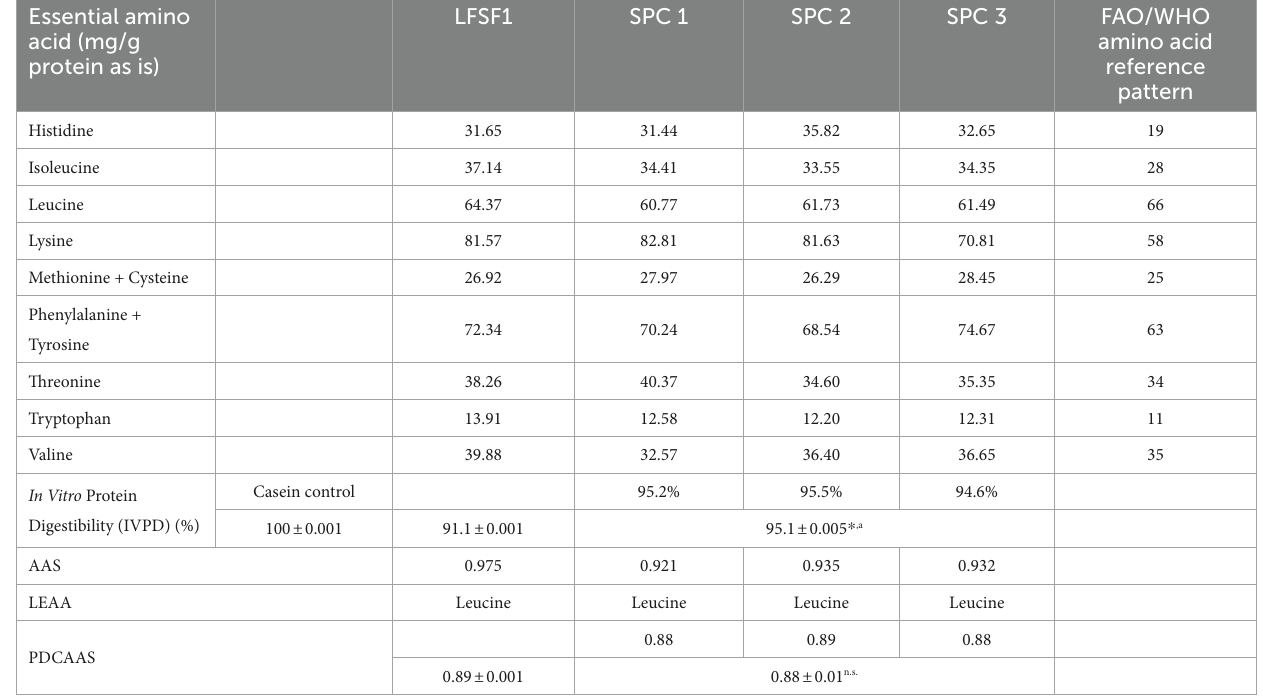
TABLE 5 Protein digestibility corrected amino acid score (PDCAAS) for LFSF1 and its SPCs at the large-scale production trials. Essential amino acid (mg/g protein as